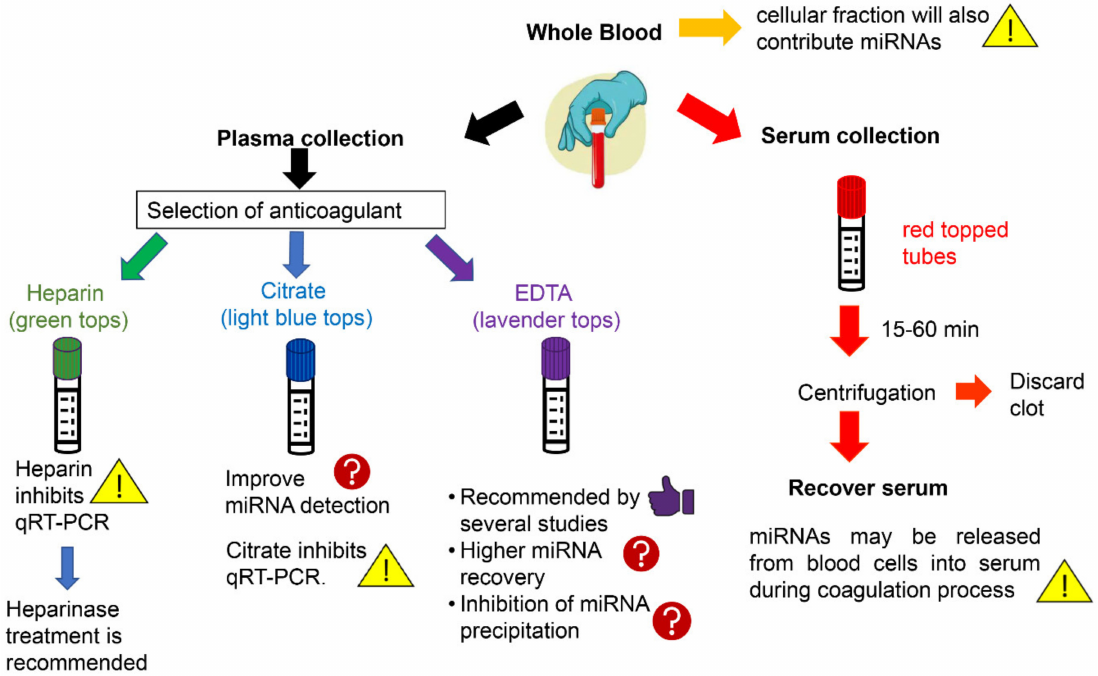
Figure 1. An overview of the effect of the different blood fractions and anticoagulants that are used for plasma isolation, on miRNA detection in circulation. The first step is the choice of blood fraction (whole plasma, serum, or plasma) to be used for miRNA detection. When plasma is selected then the effect of the anticoagulant on miRNA expression levels should be taken into account, and in general, heparin is not recommended for RNA studies, because of interference with downstream applications. Thumbs- up symbol ( ) indicates that EDTA should be used as an anticoagulant for the collection of plasma samples. Warning signs (!) show factors that have been verified experimentally by multiple studies to affect the detection of miRNAs in circulation, while question marks (?) illustrate factors that may have an impact on miRNAs detection and that should be examined further.